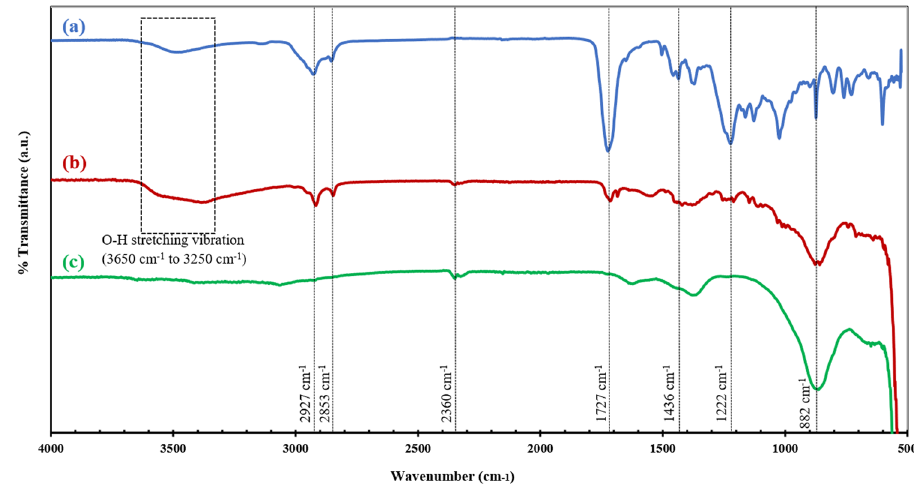
Figure 4: FTIR spectra of ( a ) SMEAF, ( b ) ZnO SMEAF , and ( c ) ZnO Chem